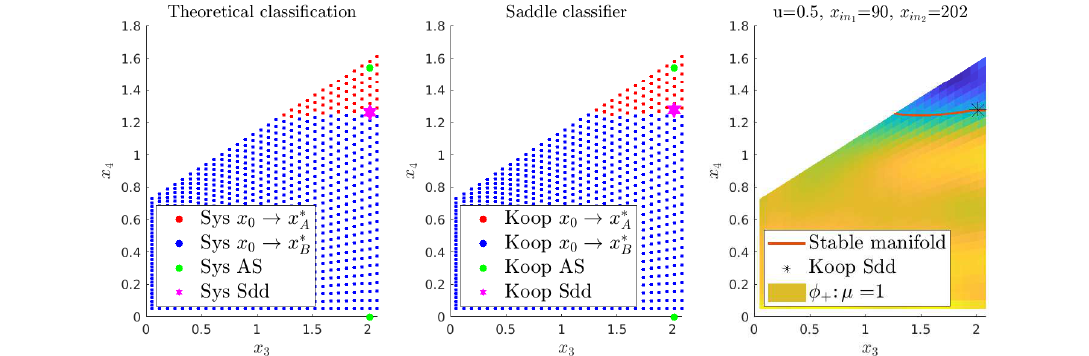
Figure 7: Theoretical, saddle based classification of initial conditions, and eigenfunction with the corresponding saddle point and stable